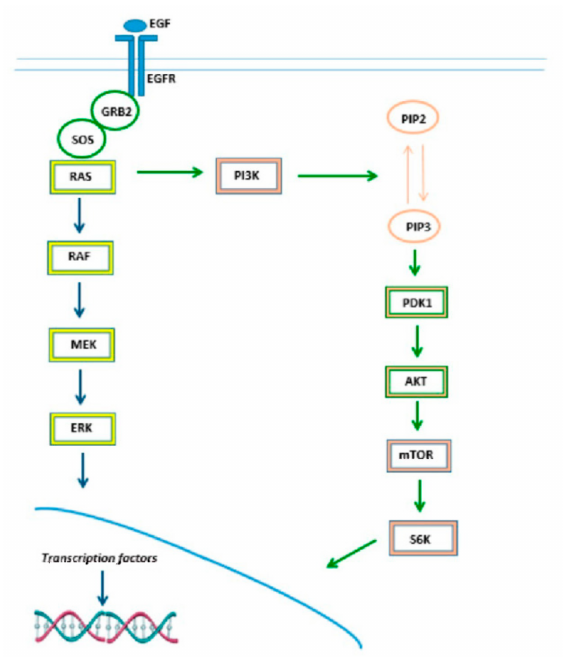
Figure 2. MAPK/ERK and PI3K/Akt/mTOR signaling